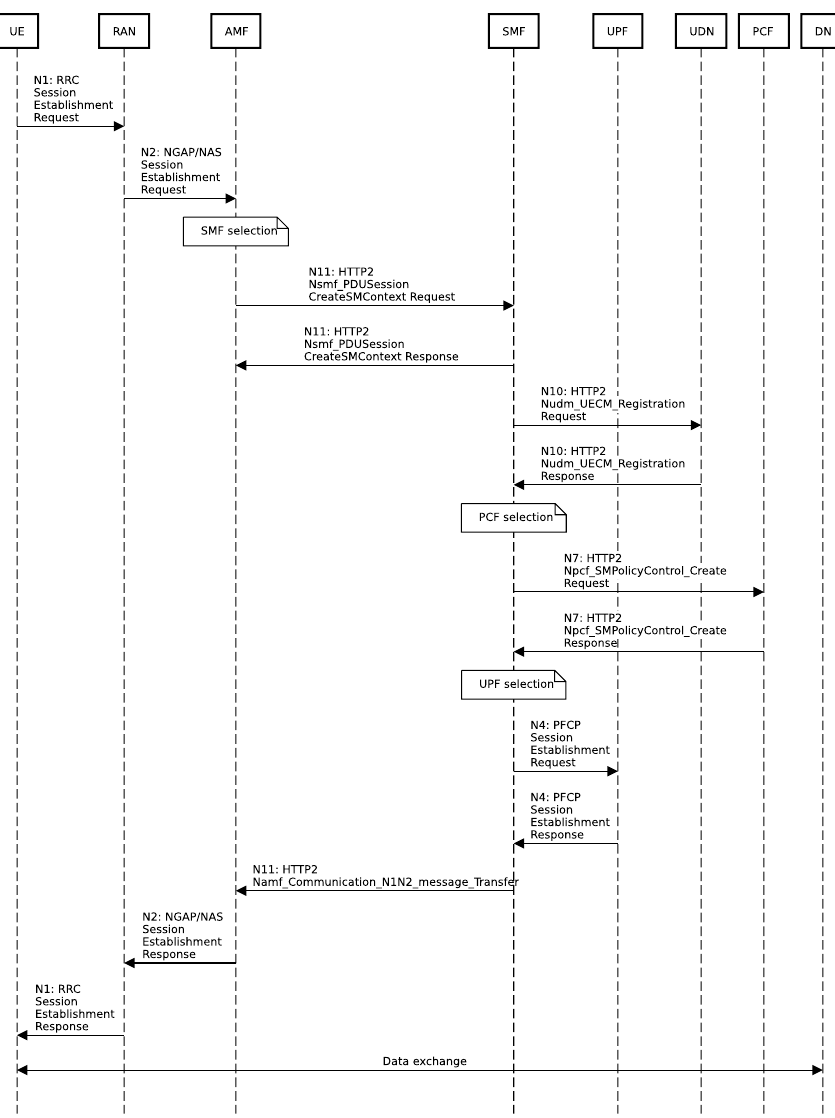
Fig. 2 Subscriber Session Establishment Procedure: A UML sequence diagram explaining the process for the establishment of subscriber PDU